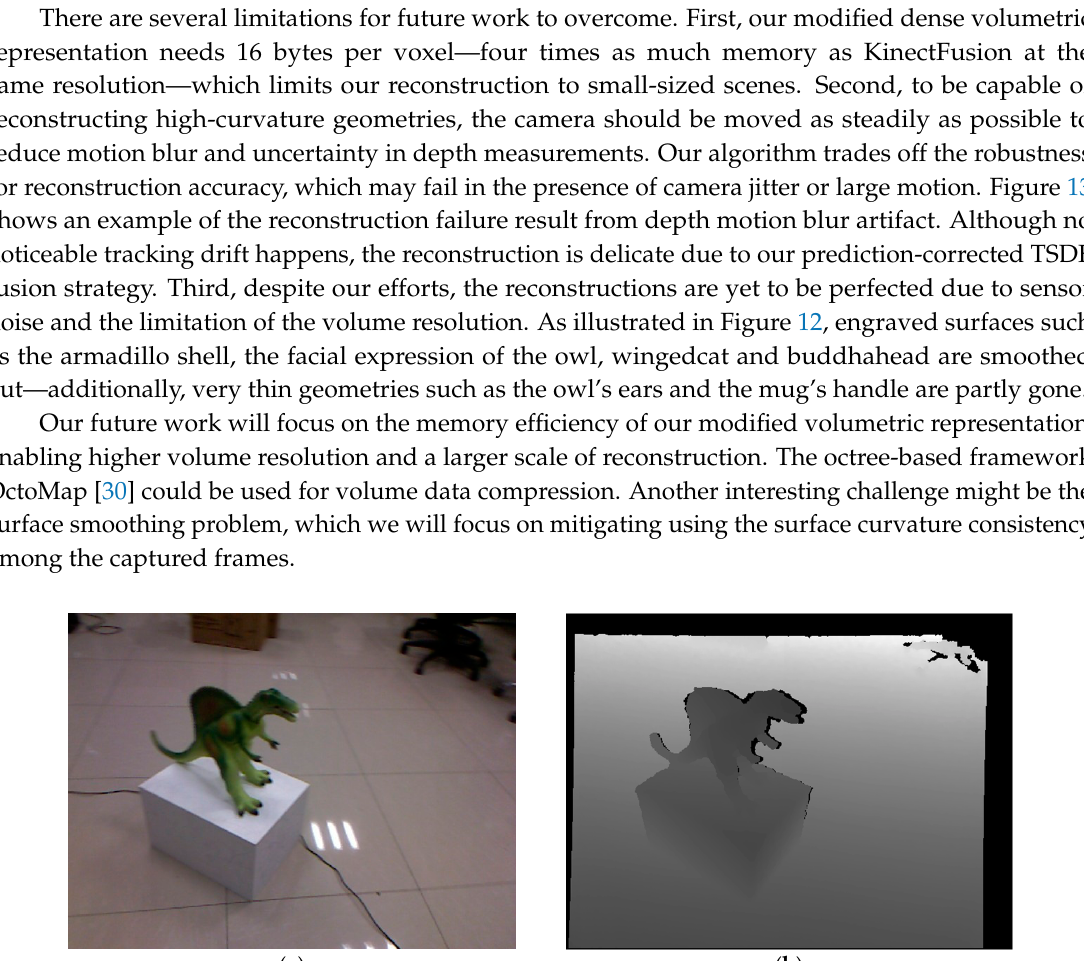
Figure 12. Close-up views of the reconstructions, colored with C2M distances. The synthetic data are ( a ) armadillo; ( b ) dragon; ( c ) bunny; and the real-world data are ( d ) lambunny; ( e ) owl; ( f ) wingedcat; ( g ) buddhahead; ( h ) tooth; and ( i ) mug. The odd rows are reconstructions of KinectFusion [1] as a comparison, and the even rows are of our